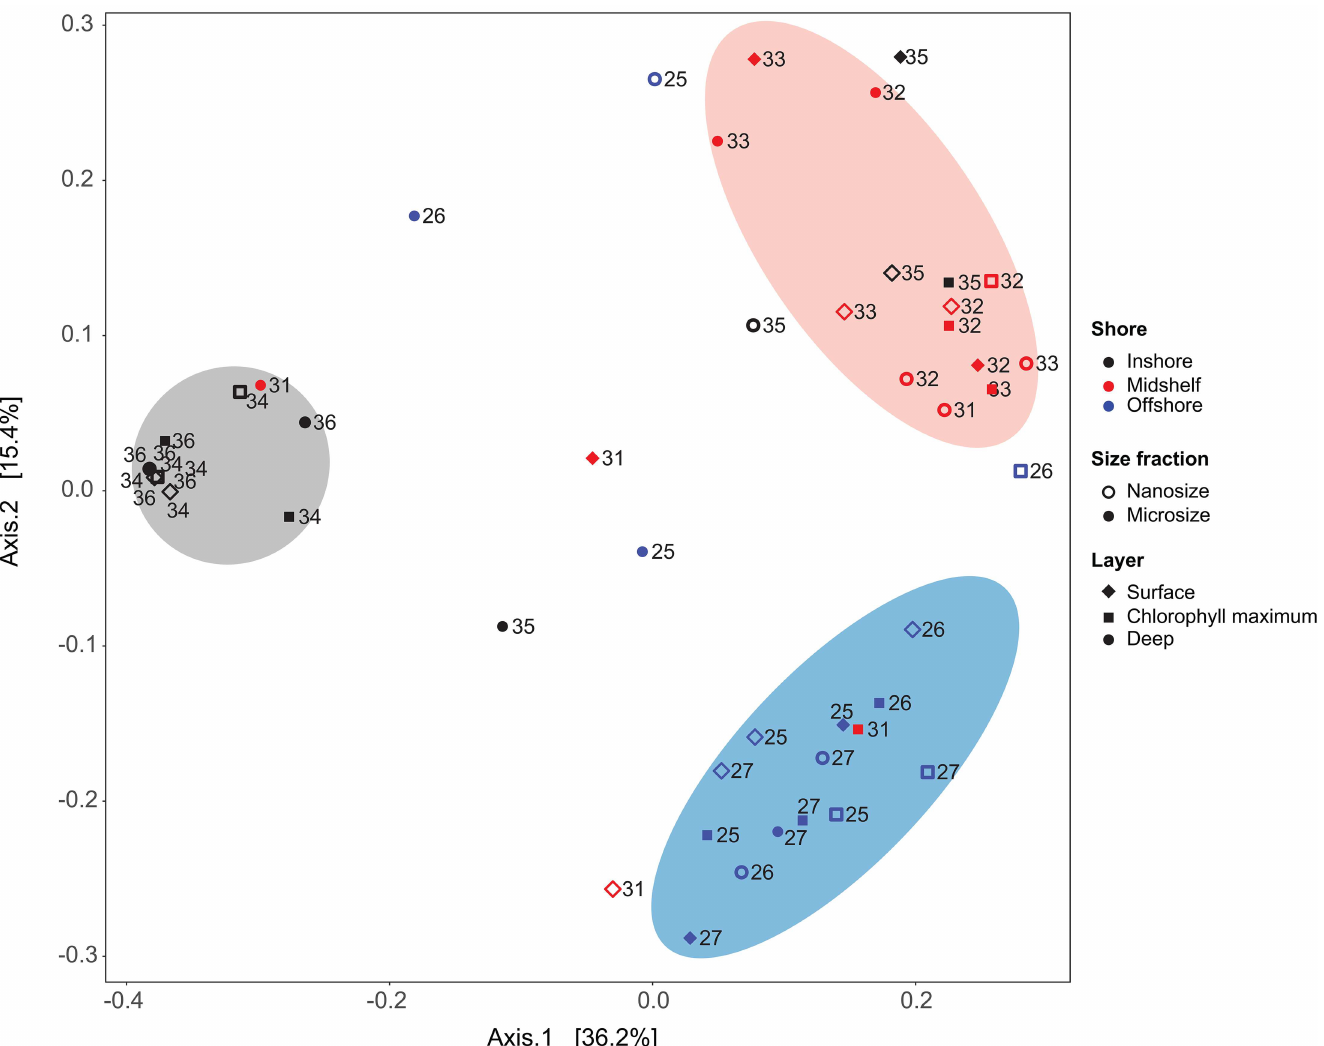
Fig 5. Principal coordinate analysesusing Unifrac dissimilarity metric (HTS data) revealsthree clusters emerge that generally correspond with inshore (gray), midshelf (red) and offshore (blue) samples. The clusters show some overlapbetweenmidshelf and offshore (red symbols within the blue cluster), and betweenthe midshelf and inshore(red within the gray cluster), but little overlapbetween inshoreand